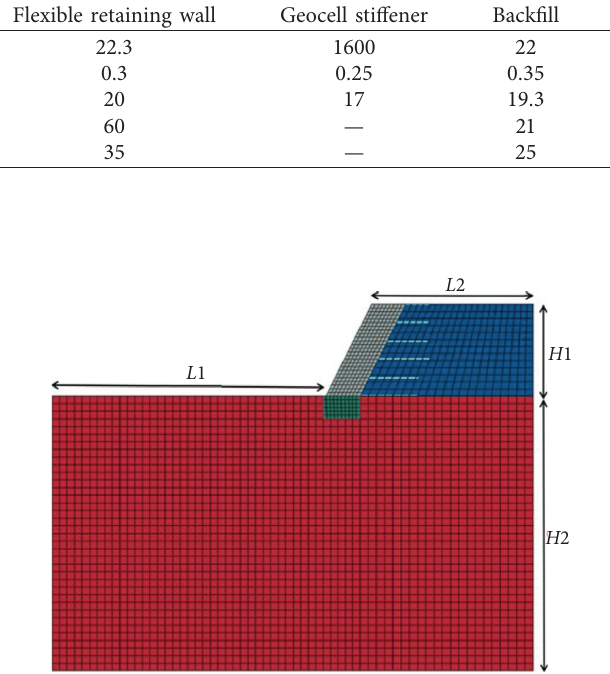
Figure 7: Numerical model mesh and size of calculation parameters.